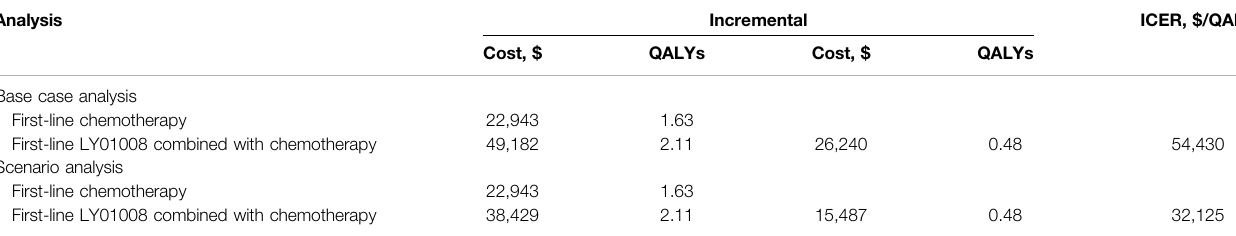
TABLE 2 | Summary of simulation results. Analysis